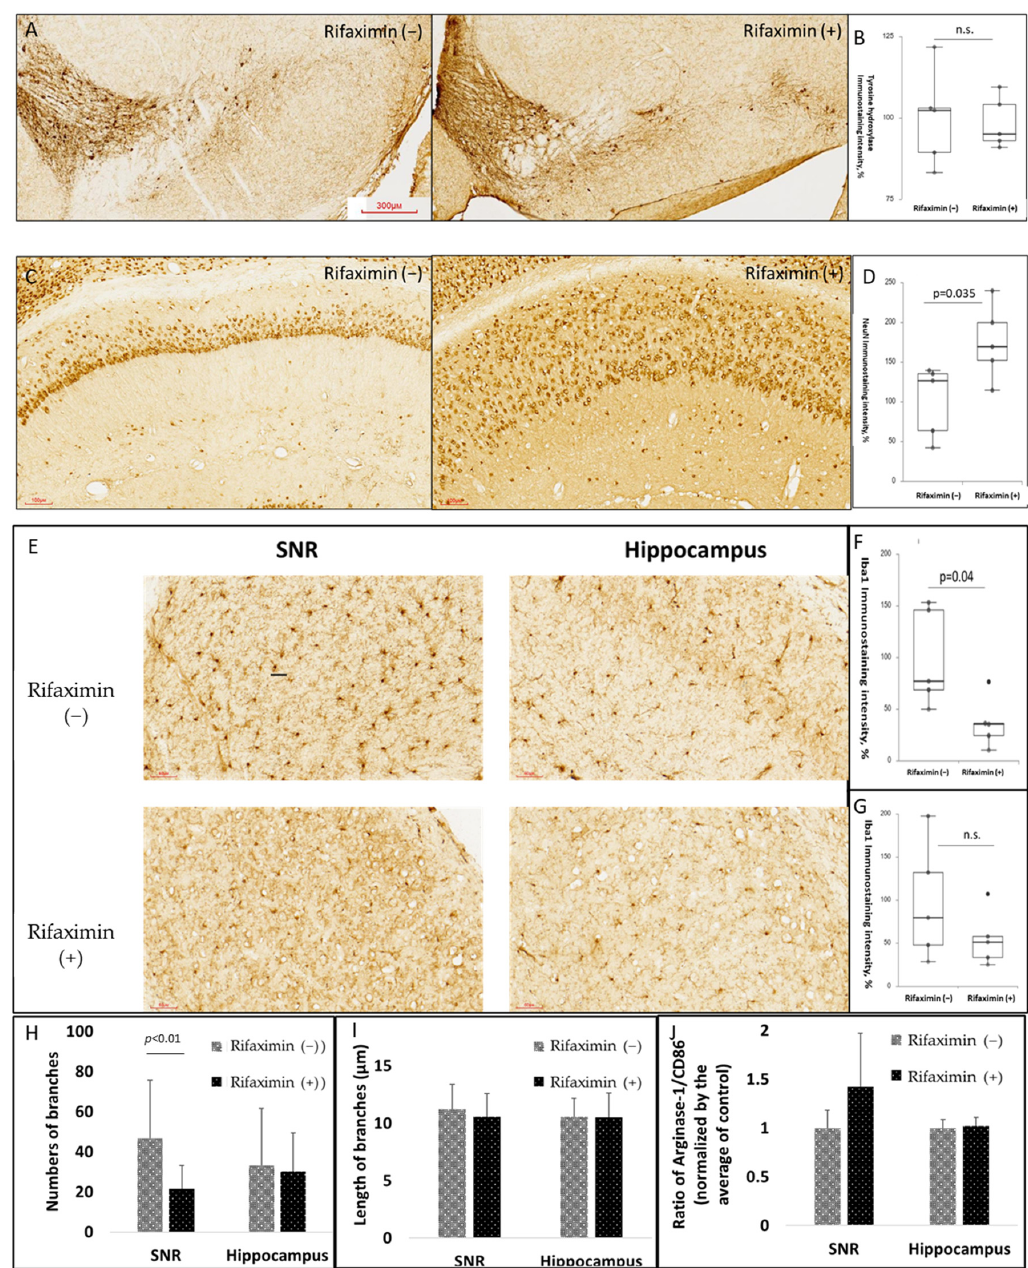
Figure 4. Effect of rifaximin treatment on neuroprotection and neuroinflammation in MitoPark mice. The quantification of neuronal survival, microglial activation, and proinflammatory cytokines in the brains of MitoPark mice. ( A , B ) Representative immunohistochemistry (IHC) images of tyrosine hydroxylase (TH), dopaminergic neuron markers, and immunoreactivity in the midbrain substantia nigra (SNR) of the MitoPark mice that were or were not treated with rifaximin. ( C , D ) Representative IHC images of neuronal nuclear protein (NeuN), neuronal markers, and immunoreactivity in the hippocampus of the MitoPark mice that were or were not treated with rifaximin. ( E – G ) Representative IHC images of ionized calcium-binding adapter molecule 1 (Iba1), microglia markers, and immunoreactivity in the midbrain substantia nigra and hippocampus of the MitoPark mice that were or were not treated with rifaximin. ( H , I ) The morphological analysis of the stained microglia by the numbers of branches and the length of the branches. ( J ) The ratio between M2 microglia to M1 microglia, defined by the expression level of arginase-1 and CD86, was analyzed in the midbrain SNR and hippocampus. Data are presented as mean ± standard deviation. n.s., non-significant.